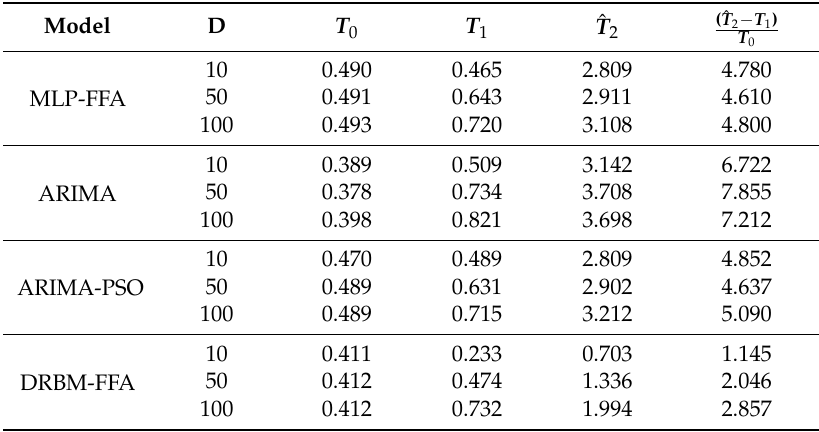
Table 5. Time Complexity